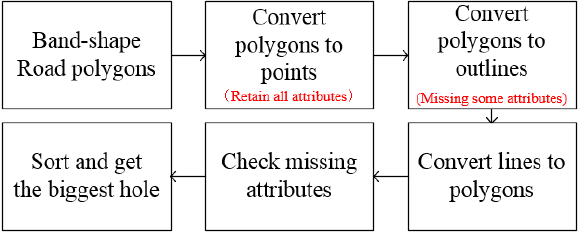
Figure 2. Flow chart of hole